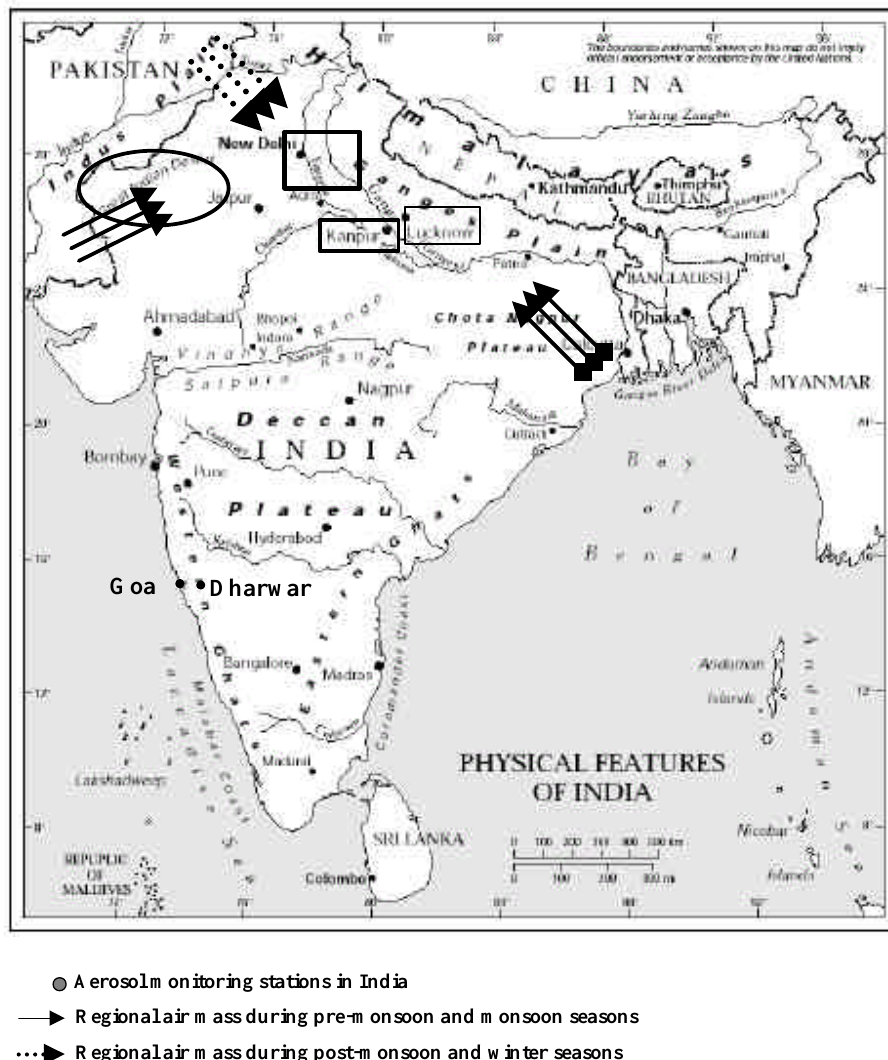
Fig. 1. Study area with regional air mass during different seasons. The industrial areas near Kanpur are marked by solid boxes and the western Thar Desert is shown by